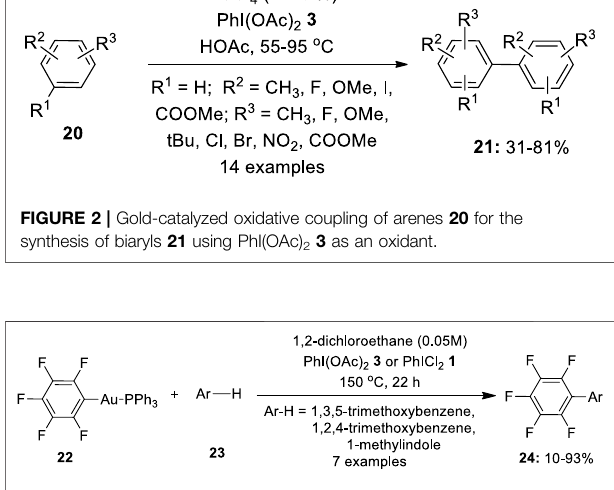
FIGURE3 | Gold-catalyzedsynthesis ofbiaryls 24 viaoxidativecoupling of penta fl uorophenyl gold(I) complexes 22 with electron-rich arenes 23 using PhI(OAc) 2 3 as an